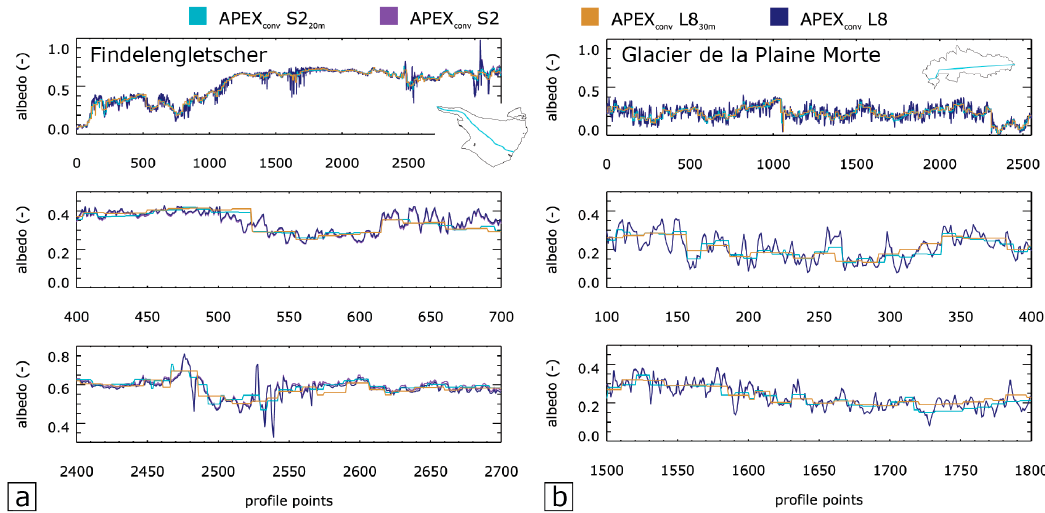
Figure 6. Simulated albedo with 2 (APEX conv S2, APEX conv L8), and 20 and 30 m, respectively (APEX conv S2 20 m , APEX conv L8 30 m ) spatial resolution plotted along ( a ) a centre-line profile of Findelengletscher and ( b ) a cross profile of Glacier de la Plaine Morte. The locations of the profiles are marked in turquoise on the insets.